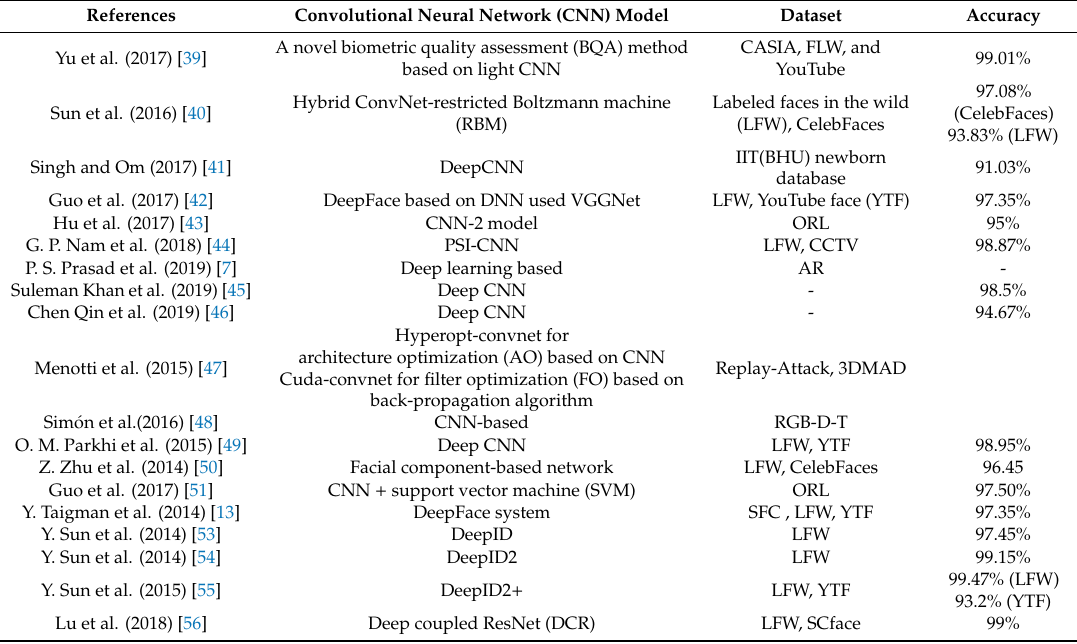
Table 3. Summary of the related